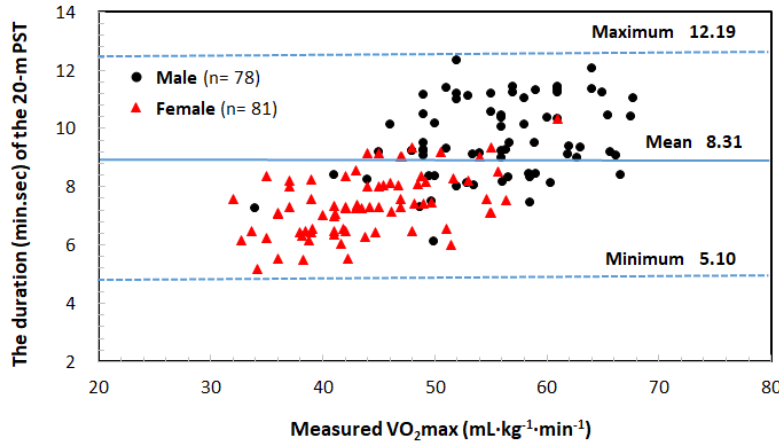
Figure 4. Scatterplot of the measured VO 2max and the duration (minutes.seconds) of the modified 20 m PST. The average test duration was 8.31 ± 1.40 (range from 5.10 to 12.19) in male and female adolescents; 9.41 ± 1.21 (range from 6.08 to 12.19) in male adolescents; and 7.24 ± 1.04 (range from 5.10 to 10.21) in female adolescents. The solid line represents the mean duration of the modified 20 m PST. Upper and lower broken lines represent the maximum and minimum durations of the modified 20 m PST.